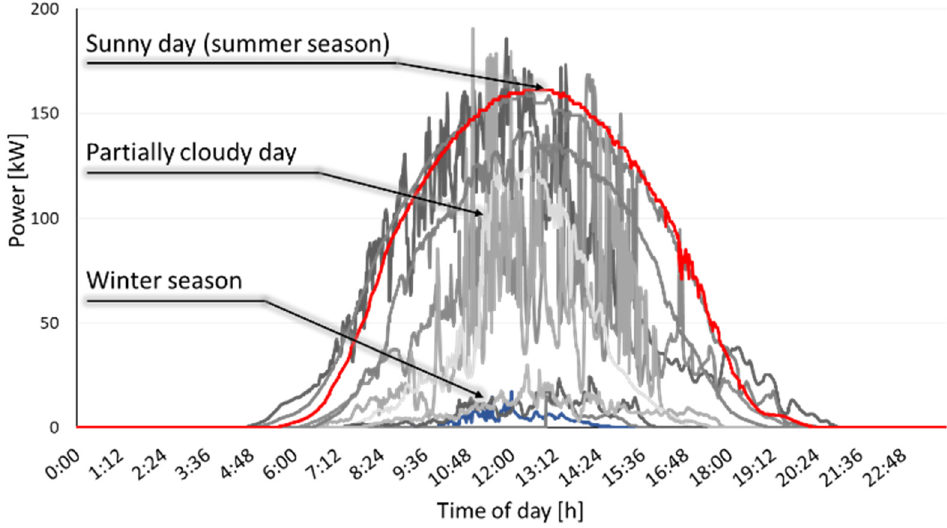
Figure 15. Daily power production profile from solar panels.